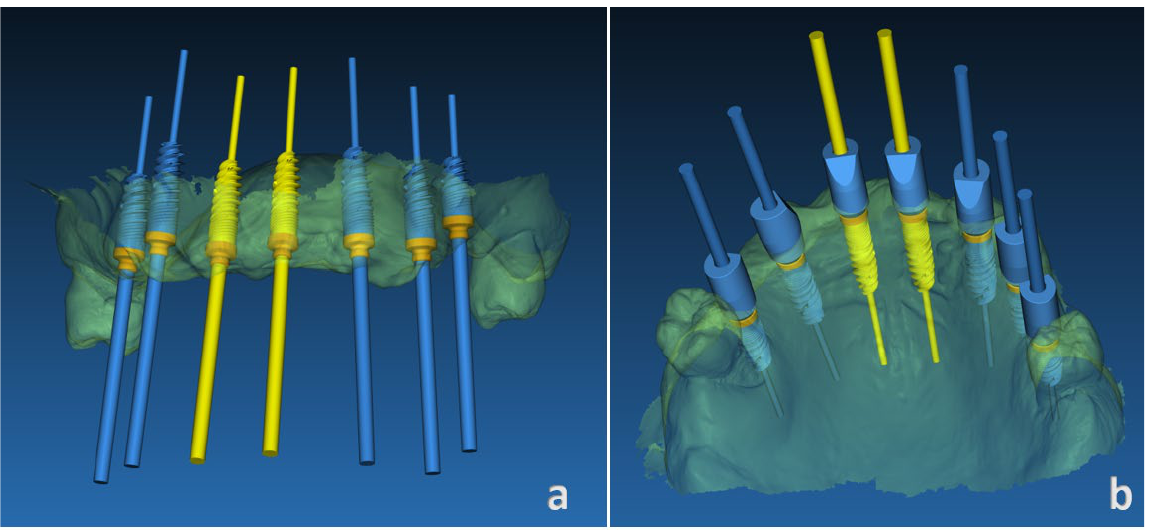
Figure 5. Virtual implant planning with OT-Equator attachments ( a ) and scan abutment library files ( b ).